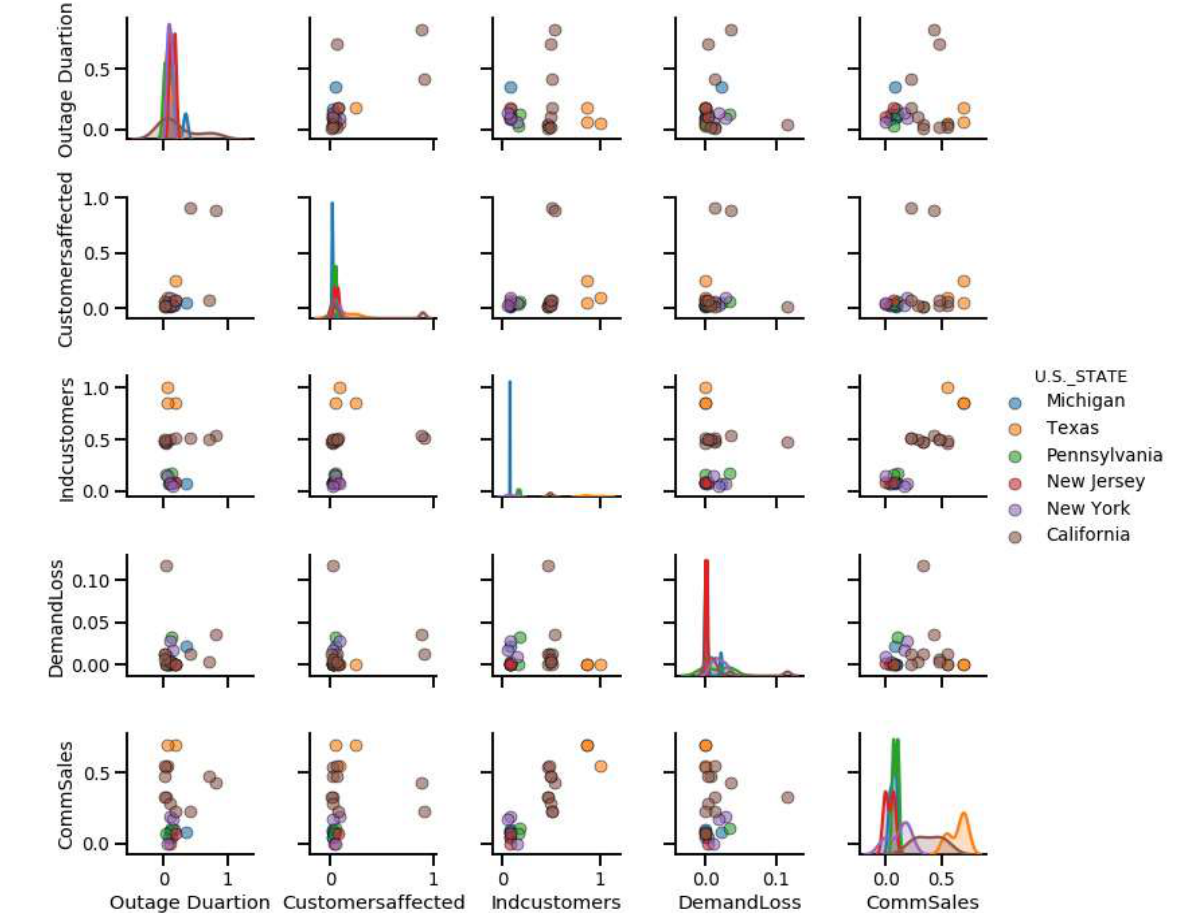
Figure 23. Top feature correlation plots for the storm disaster category.